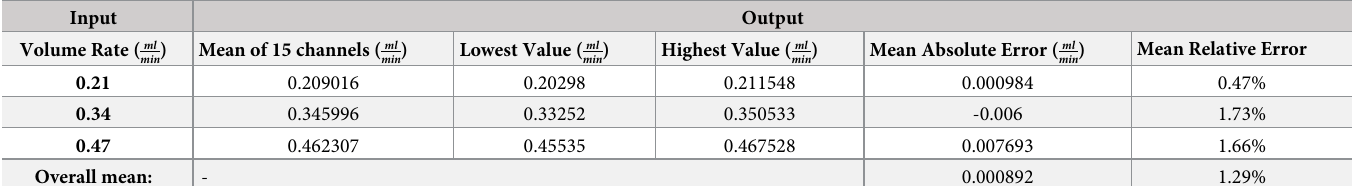
Table 3. Volumetric analysis of pumps running within the mean CSF production rate reported by Edsbagge et. al [26].